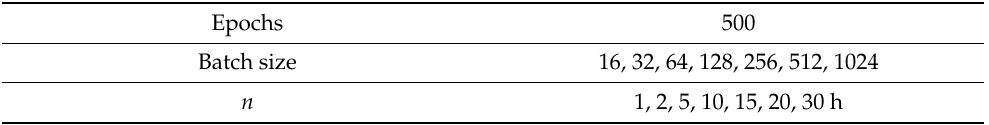
Table 5. Hyper parameters of the LSTM model.